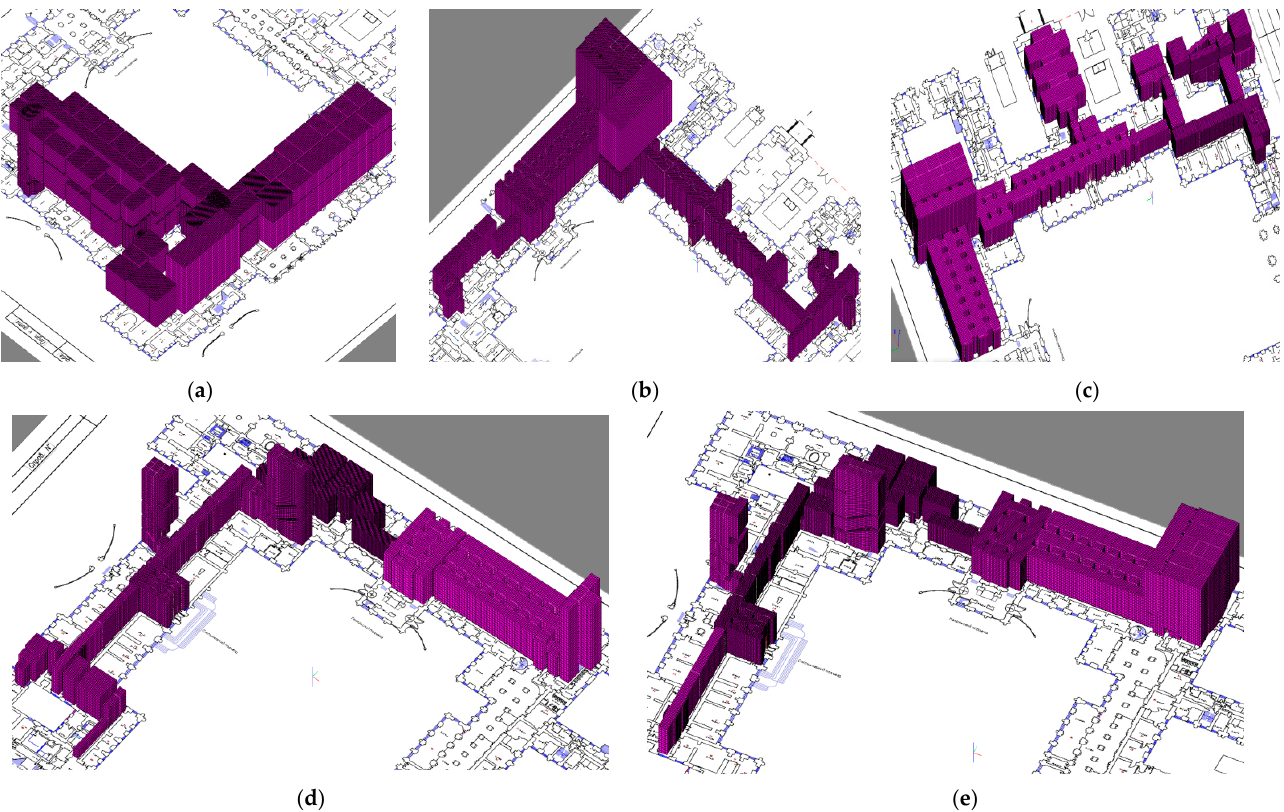
Figure 9. Calculation mesh for fire simulation in the scenario: ( a ) “The fire in the foyer of the Wooden Staircase”; ( b ) “The fire in Buffet (Rastrelli Gallery)”; ( c ) “The fire in the Commandant’s Cloakroom”; ( d ) “The fire in the foyer of the Saltykov’s Entrance”; ( e ) “The fire in the School Cloakroom”.